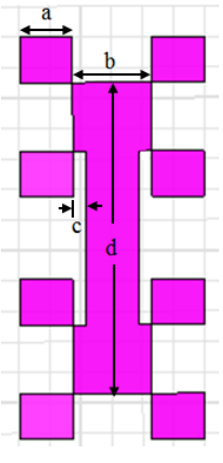
Figure 10. Fractal DGS.